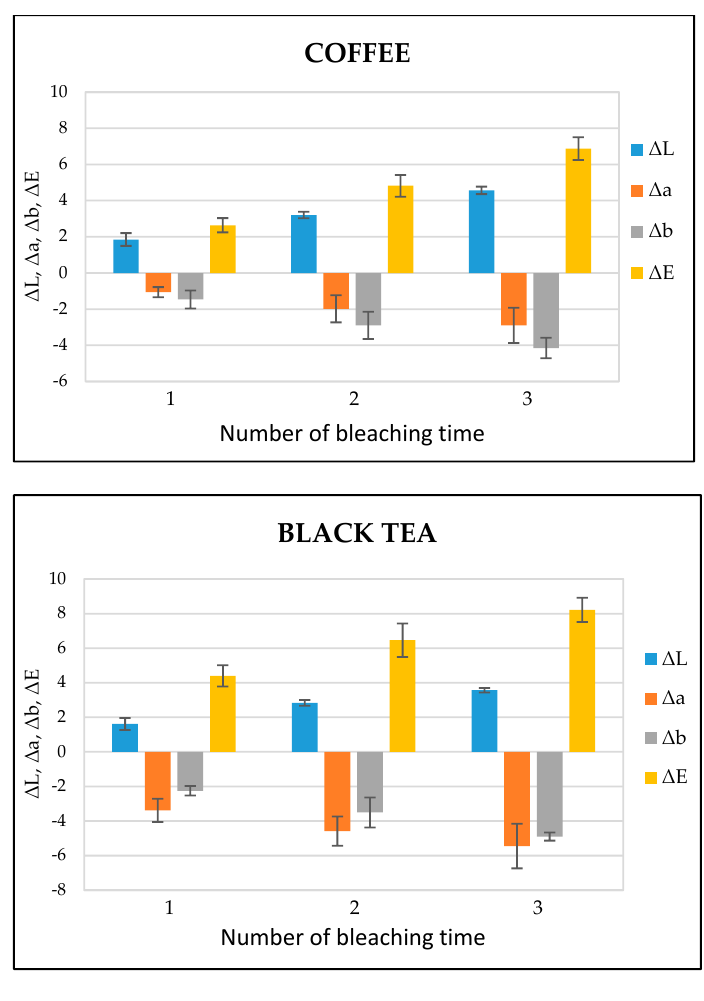
Figure 5. Δ L, Δ a, Δ b, and Δ E values of coffee- and black tea-stained bovine tooth samples treated Figure 5. ∆ L, ∆ a, ∆ b, and ∆ E values of coffee- and black tea-stained bovine tooth samples treated with dental bleaching gel ( n = 6). with dental bleaching gel ( n = 6). Table 1. Mean Δ E and standard deviation. Table 1. Mean ∆ E and standard